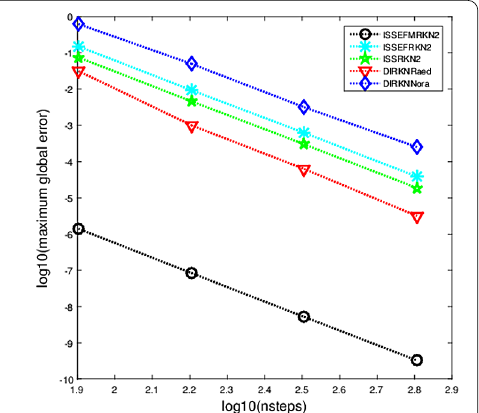
Figure 5 Maximum global error in the solution for Problem